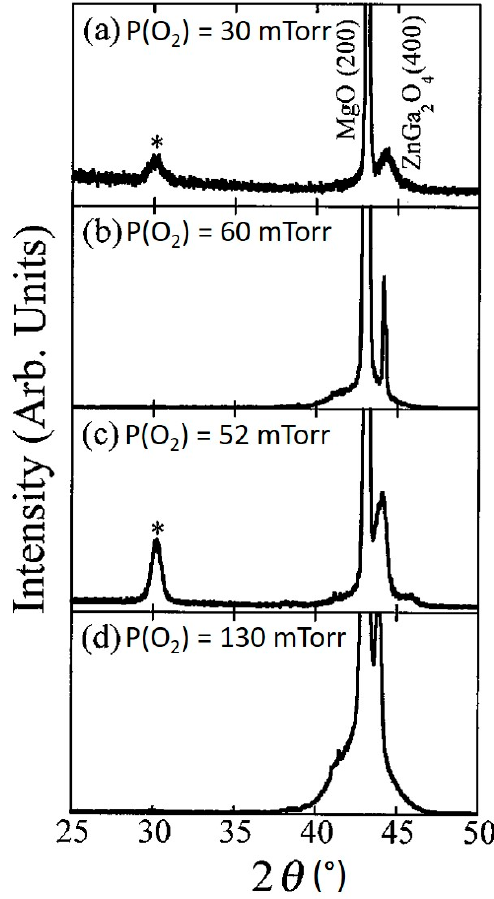
Figure 10. X-ray scans for ZnGa 2 O 4 films deposited at 650 ◦ C on MgO(100) substrates under P(O 2 ) of ( a ) 30 and ( b ) 60 mTorr with total pressure fixed at 60 mTorr; and at 700 ◦ C on MgO(100) substrates under P(O 2 ) of ( c ) 52 and ( d ) 130 mTorr with total pressure fixed at 130 mTorr using an area portion of ZnGa 2 O 4 / ZnO of 50% / 50% target [79] (with copyright permission from AIP Publishing, 2020).